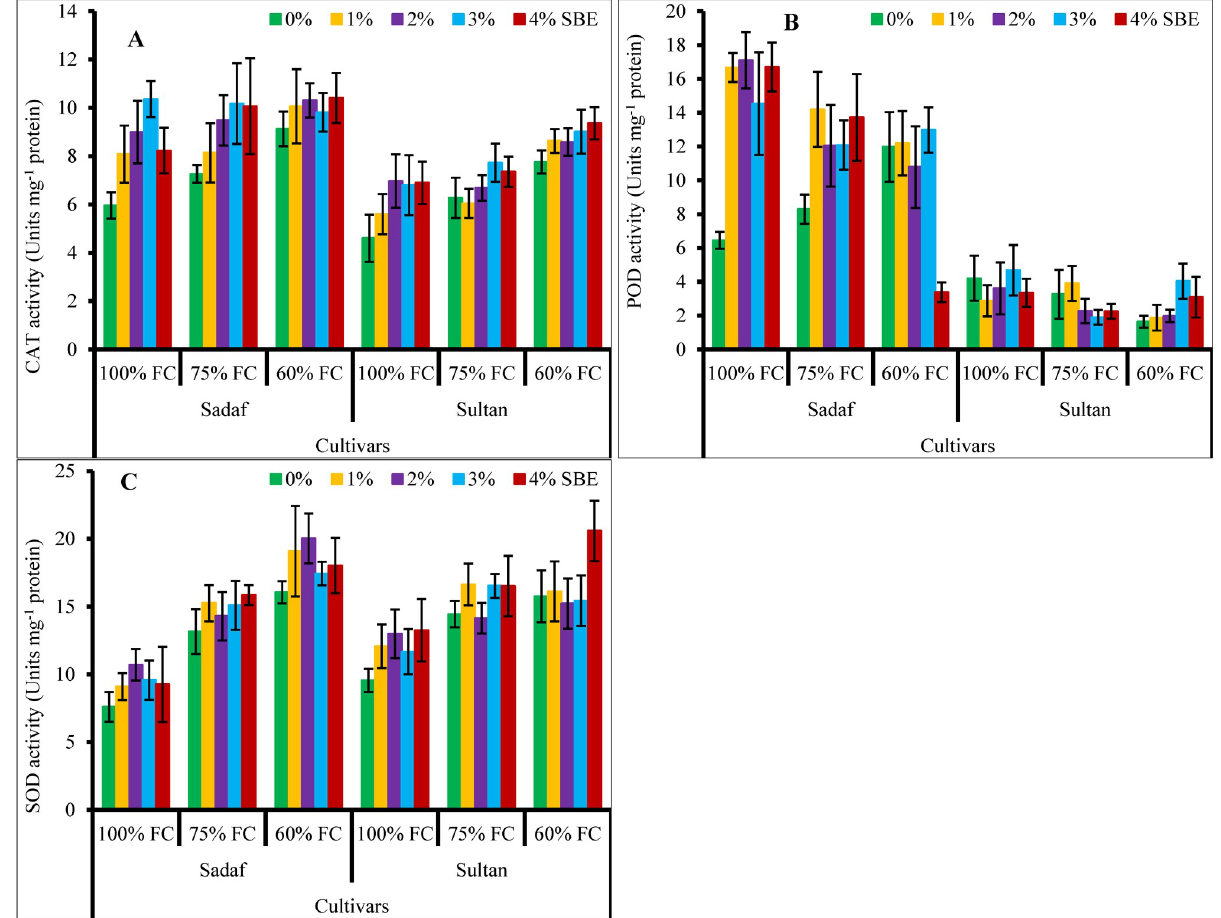
Fig 7. Supplementation of sugar beet extract (SBE) enhanced the activities of (A) CAT, (B) POD and (C) SOD enzymes of maize plants subjected to water-deficit stress ( n = 3; Mean ± S.E.).